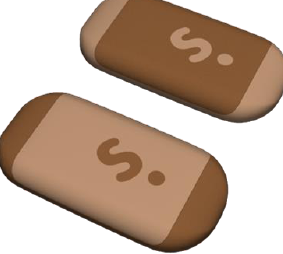
Figure 1. The inertial measurement unit used in intervention group 2.